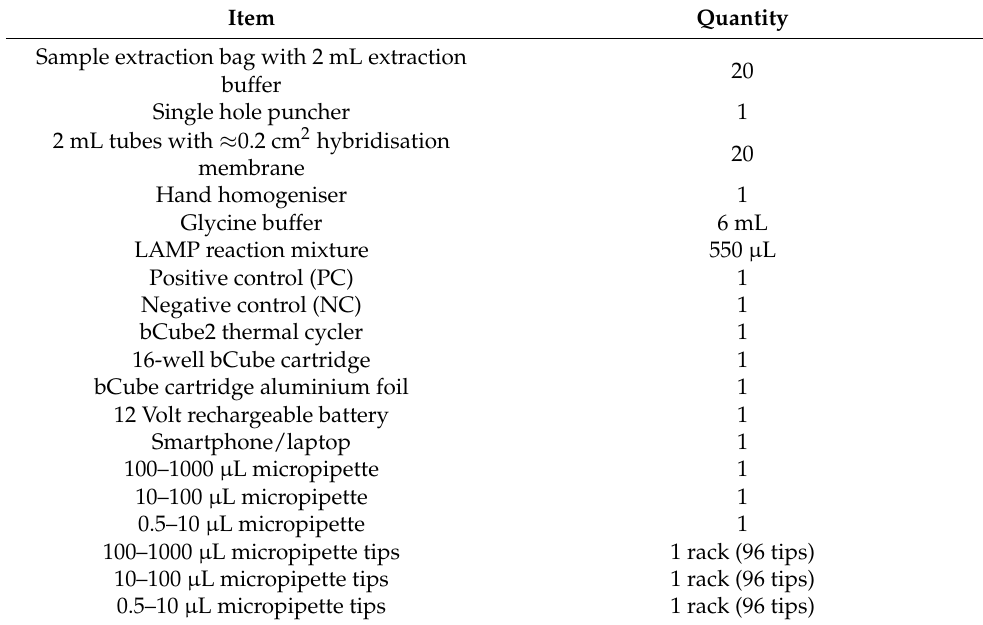
Table 1. List of reagents, disposables, and tools used for in-field ToLCNDV detection by real-time LAMP